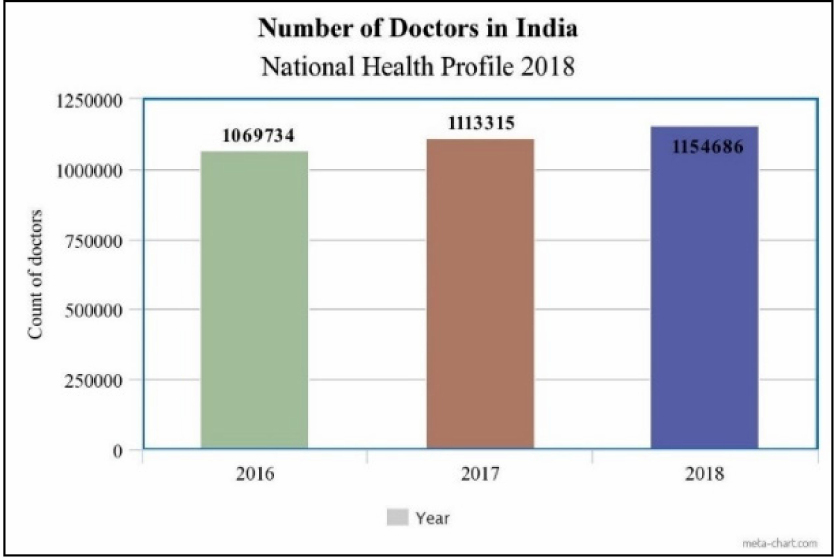
Figure 7. Number of doctors in India [17].